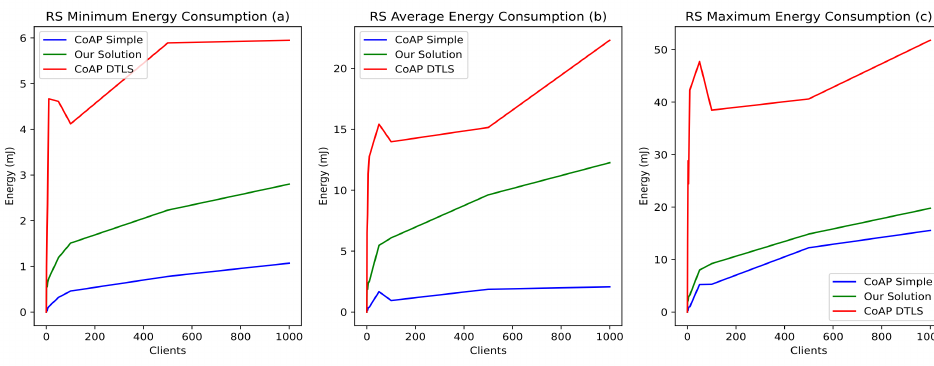
Figure 8. CoAP Server response execution time on the resource server.